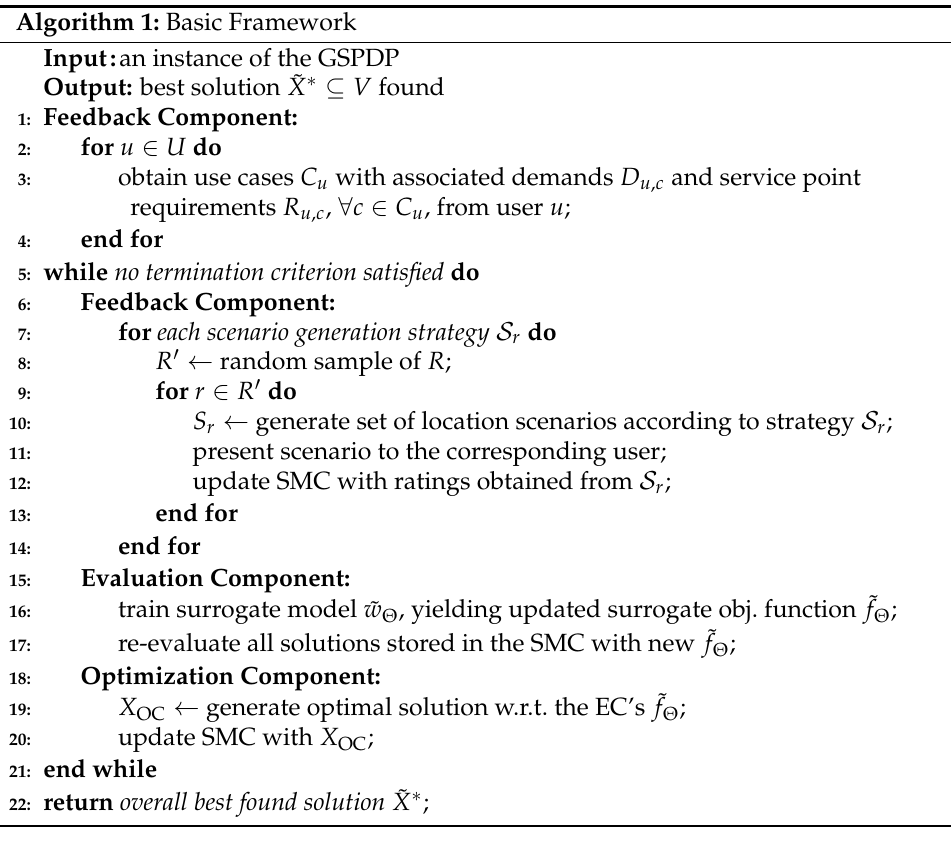
Algorithm 1: Basic